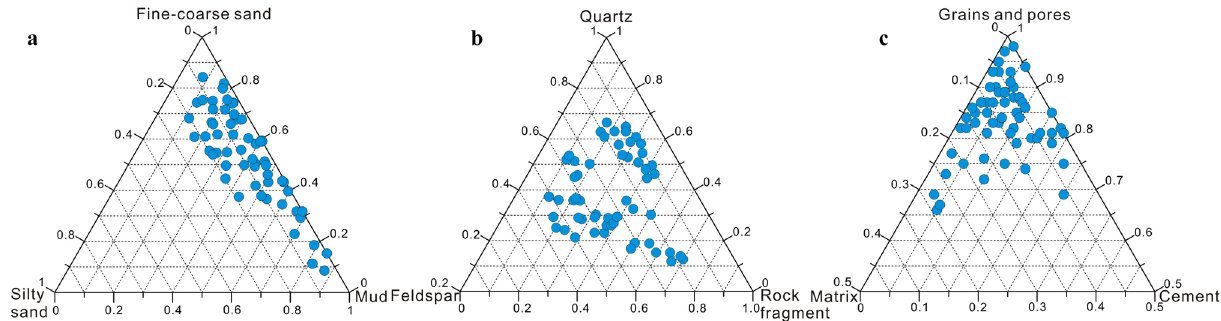
Fig. 3 The compositions of Oligocene sandstone reservoirs in Leng- dong area, Qaidam Basin. a Triangular diagram of main components of sandstone reservoirs. Three end members on the classification tri- angle chart fine-coarse sand, silty sand and mud. b Triangular dia-